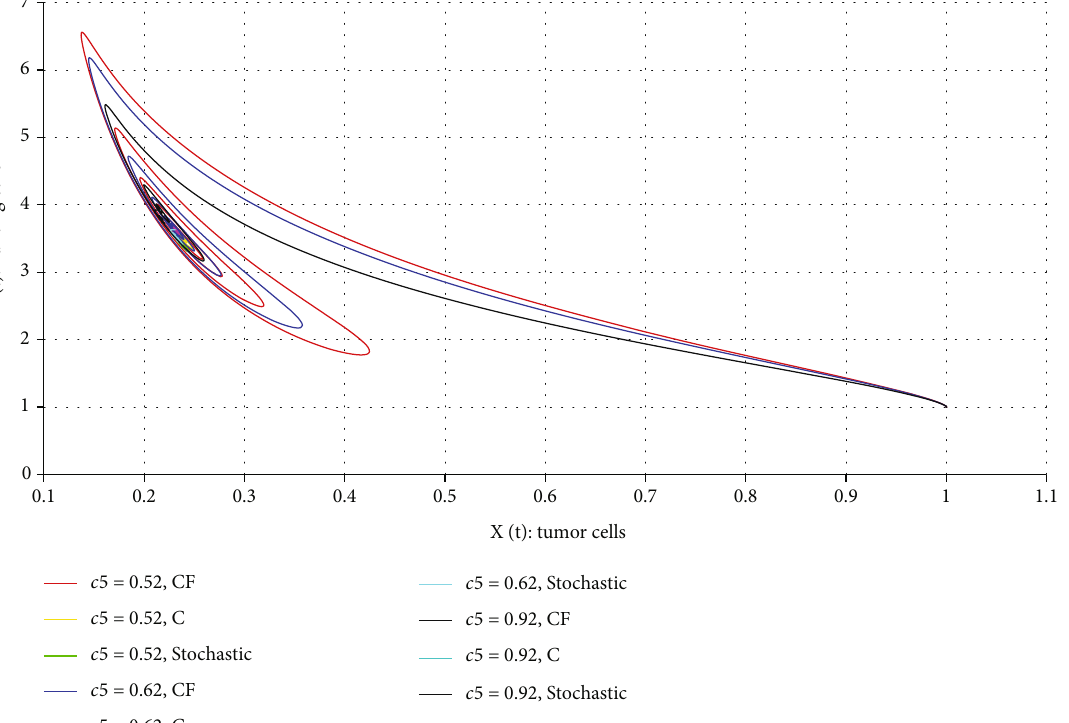
Figure 15: Phase portrait of the piecewise systems (15) and (16) projected onto the XZ plane for the parameter values of c = 0 : 21 , c = 0 : 55 , c = 0 : 39 , c = 0 : 21 , c = 2 , K 0 : 2 , differentvalues of the parameter c 0 : 65 , c 3 4 6 7 8